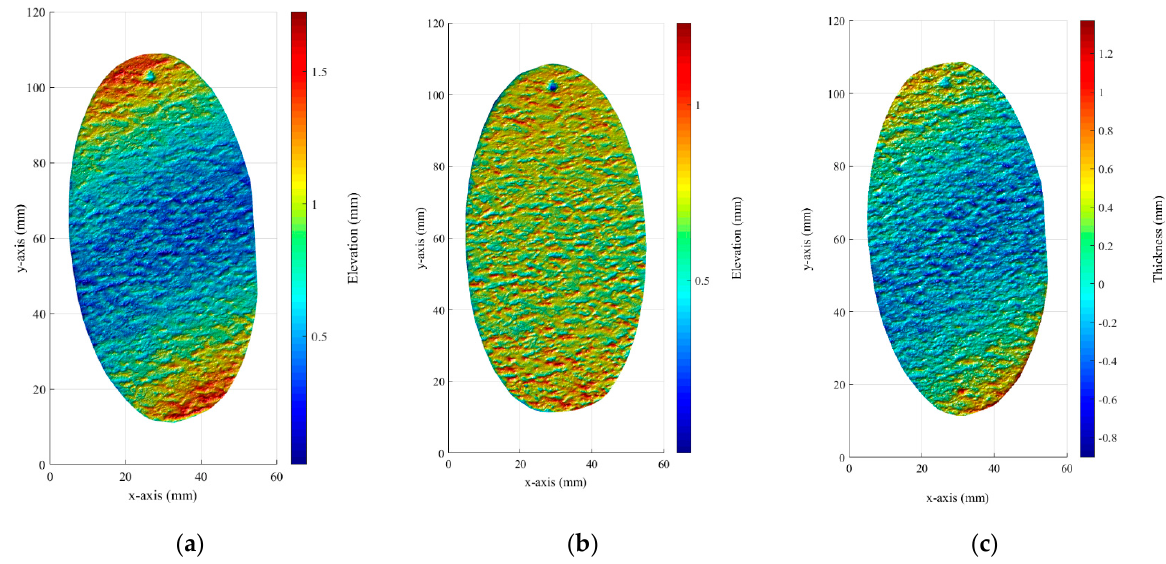
Figure 5. The contour of the roughness of the smooth fracture surface. ( a ) before shearing; ( b ) after shearing; ( c ) shear surface.